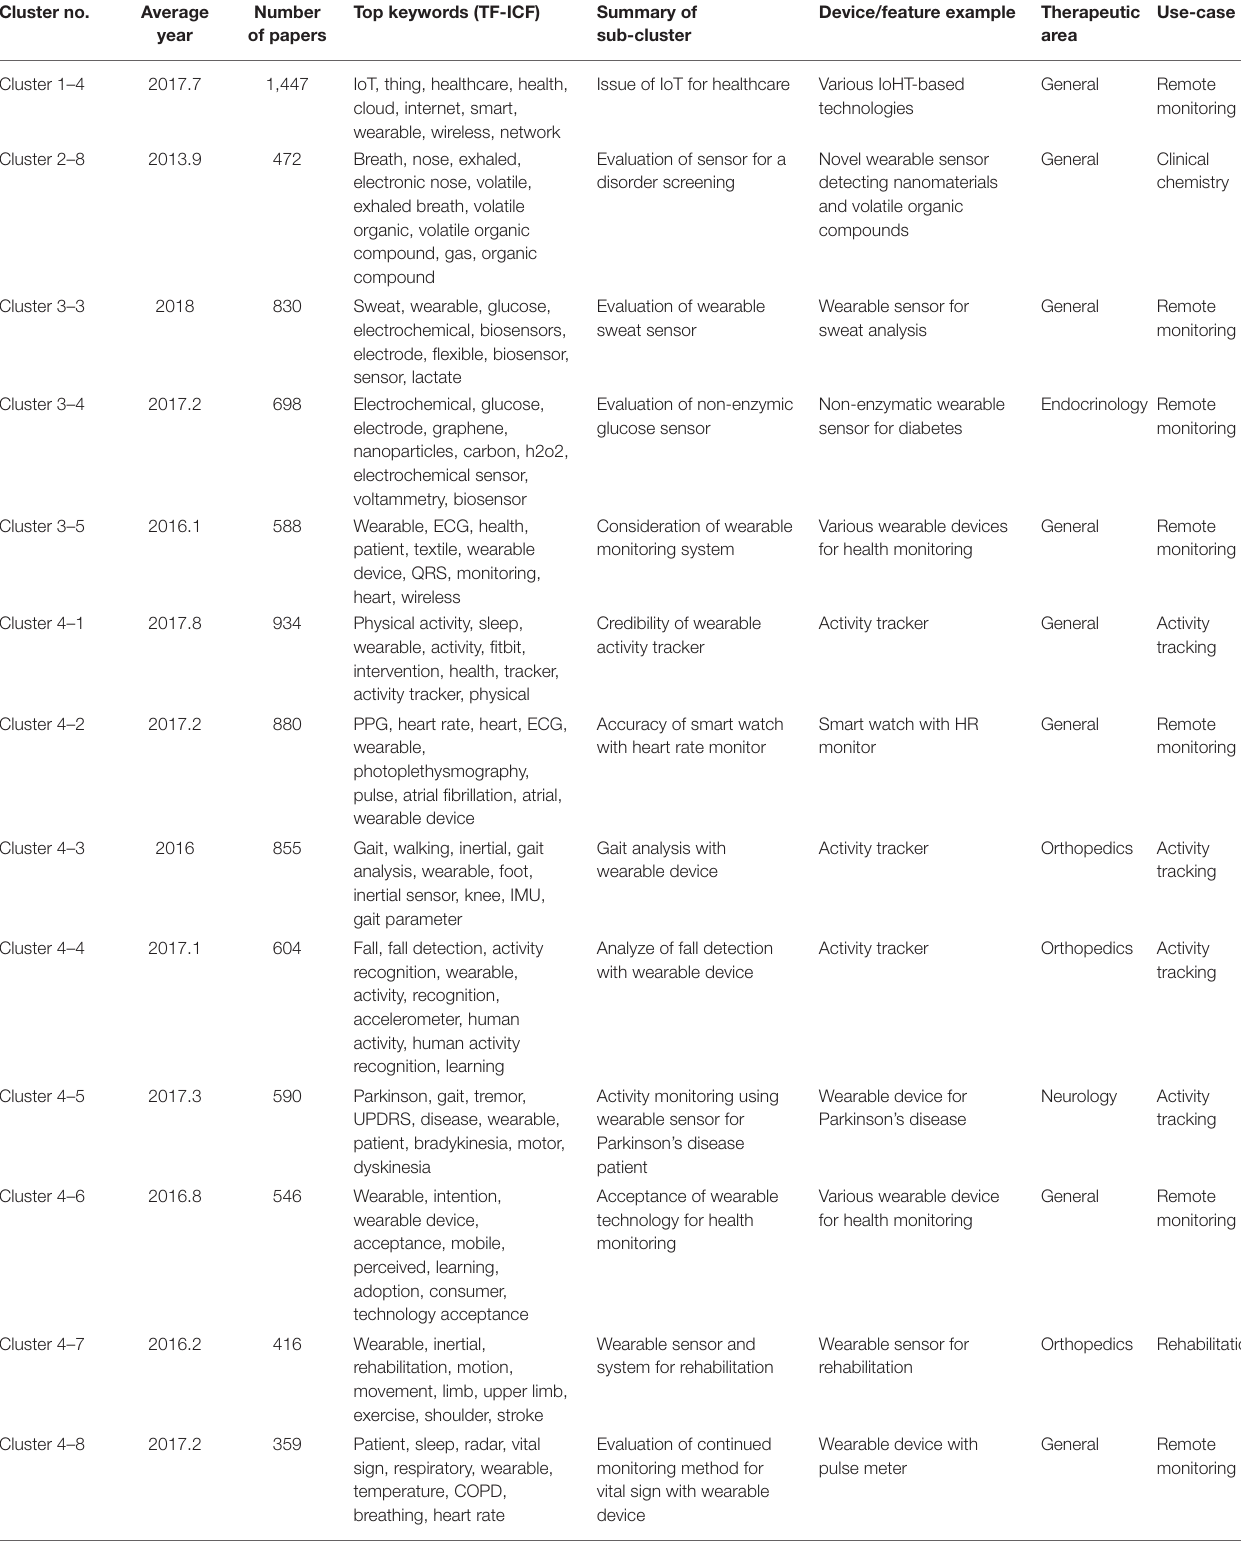
TABLE 2 | Summarization of sub-cluster focused on DCT-related IoMT/IoHT. Cluster